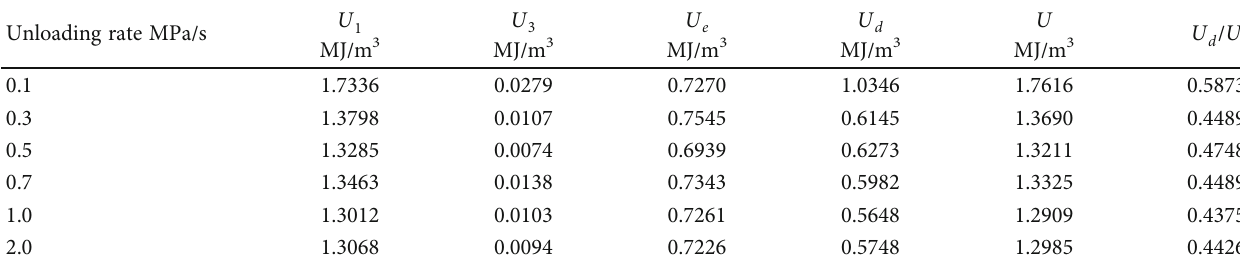
Table 2: Strain energy density at the peak point.